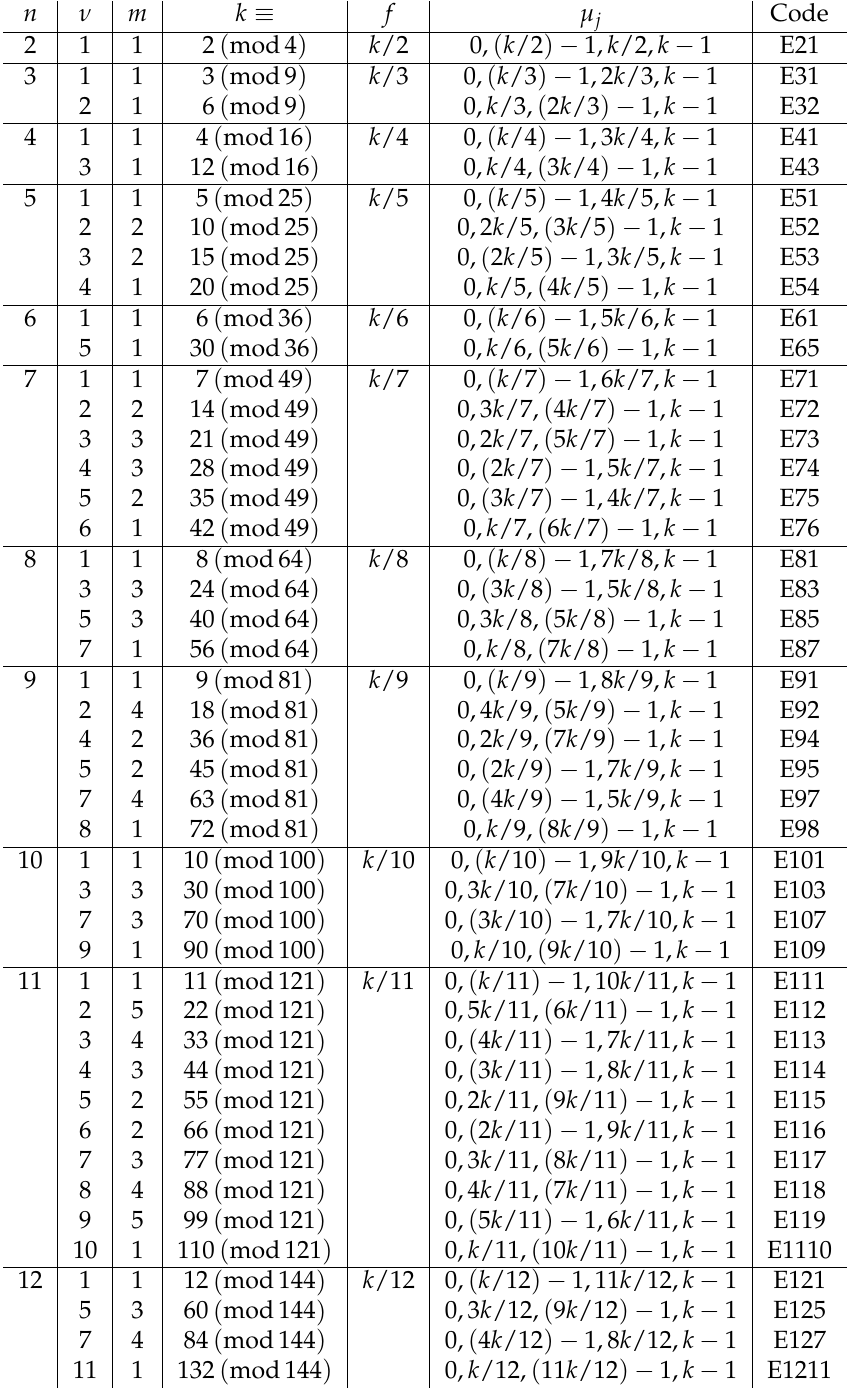
Table 4. Expressions of µ j for 2 ≤ n ≤